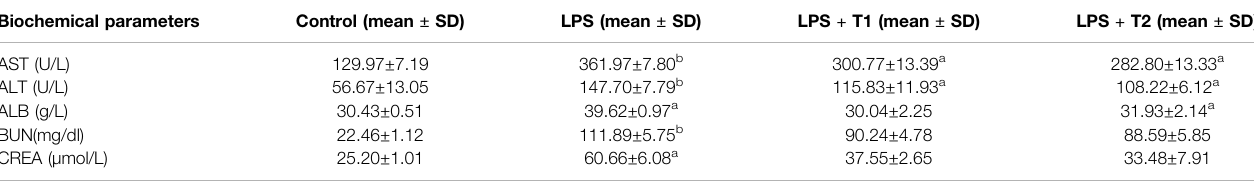
TABLE 1 | Effect of LPS and TMP on the biochemical parameters. Biochemical parameters